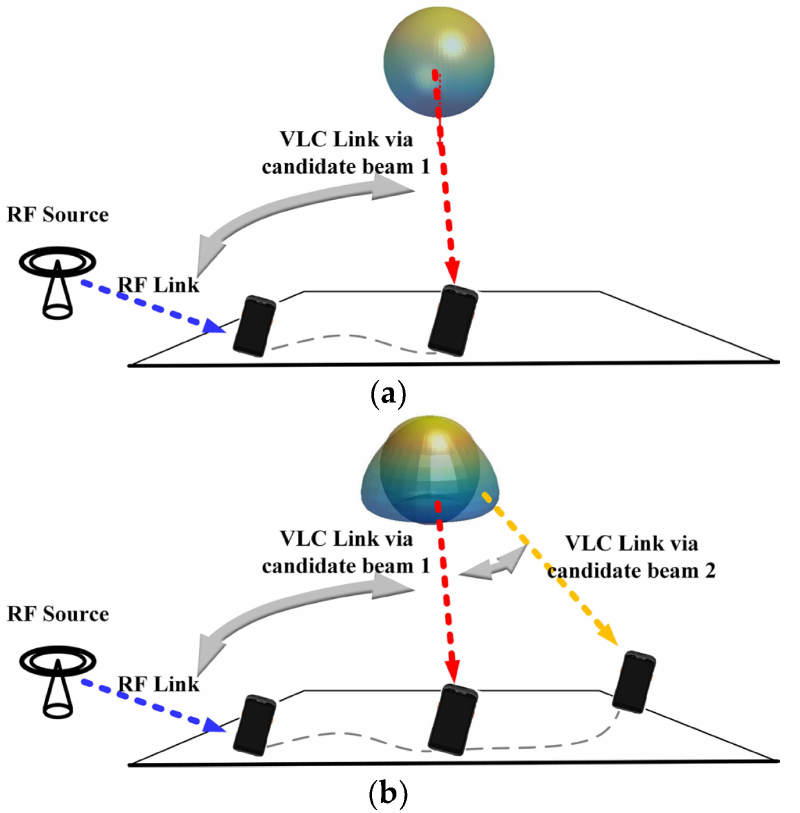
Figure 4. Indoor hybrid VLC/RF link switching illustration with ( a ) one candidate optical beam and ( b ) two candidate optical